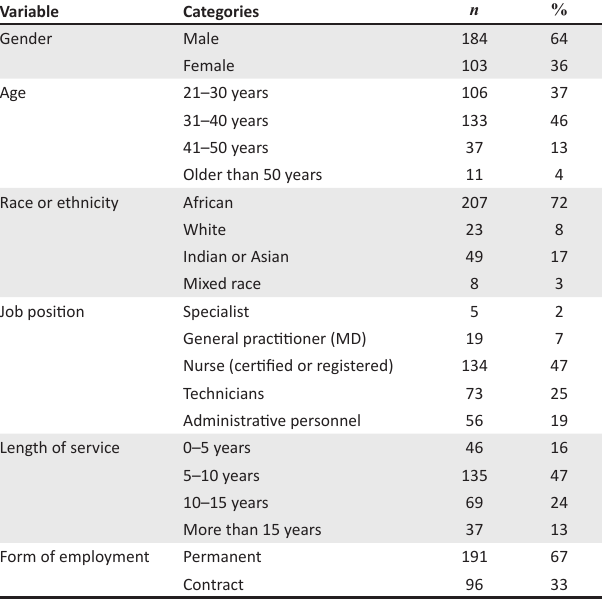
TABLE 1: Demographic profile of the